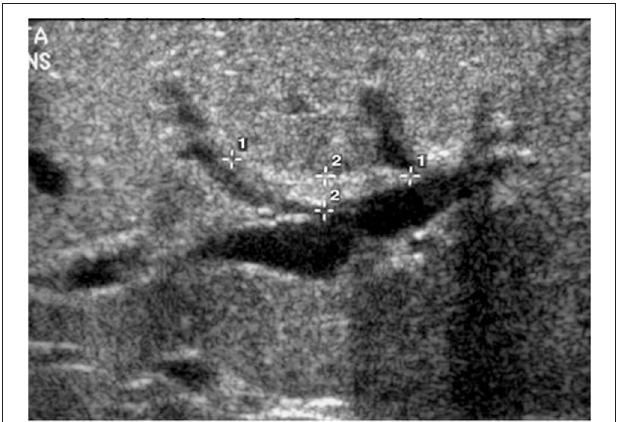
FIGURE 2 | Absent gallbladder on